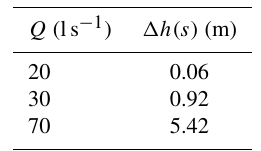
Table 2. Head loss values for each pumping rate in the case